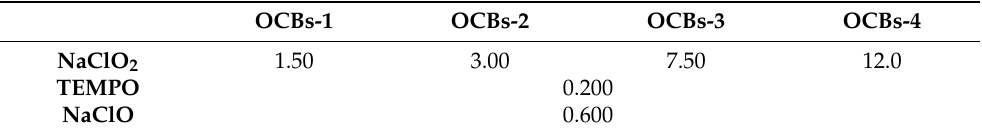
Table 3. Dosage of reagents in four different oxidation samples